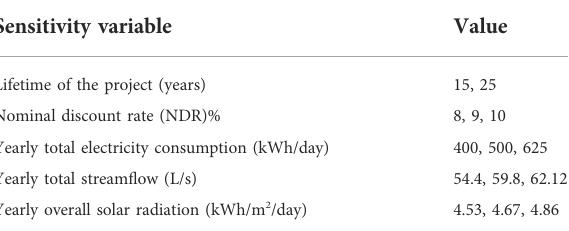
TABLE 2 Sensitivity variables.